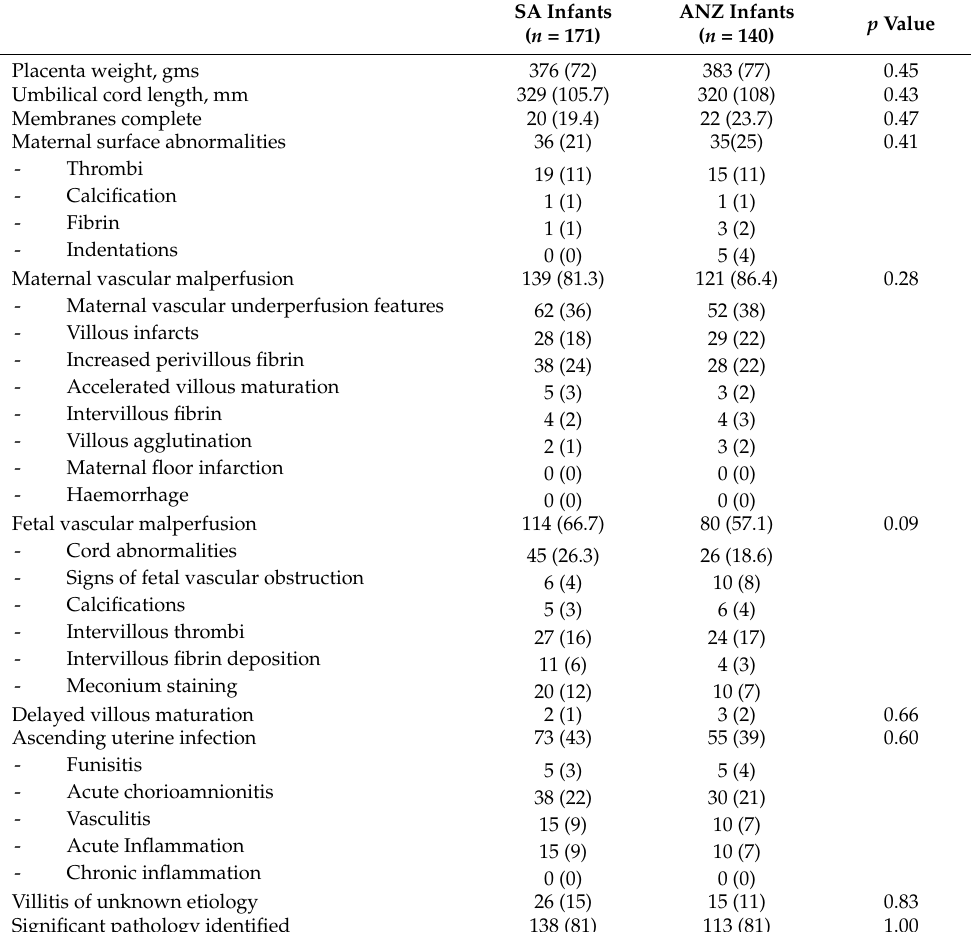
Table 2. Placental findings.